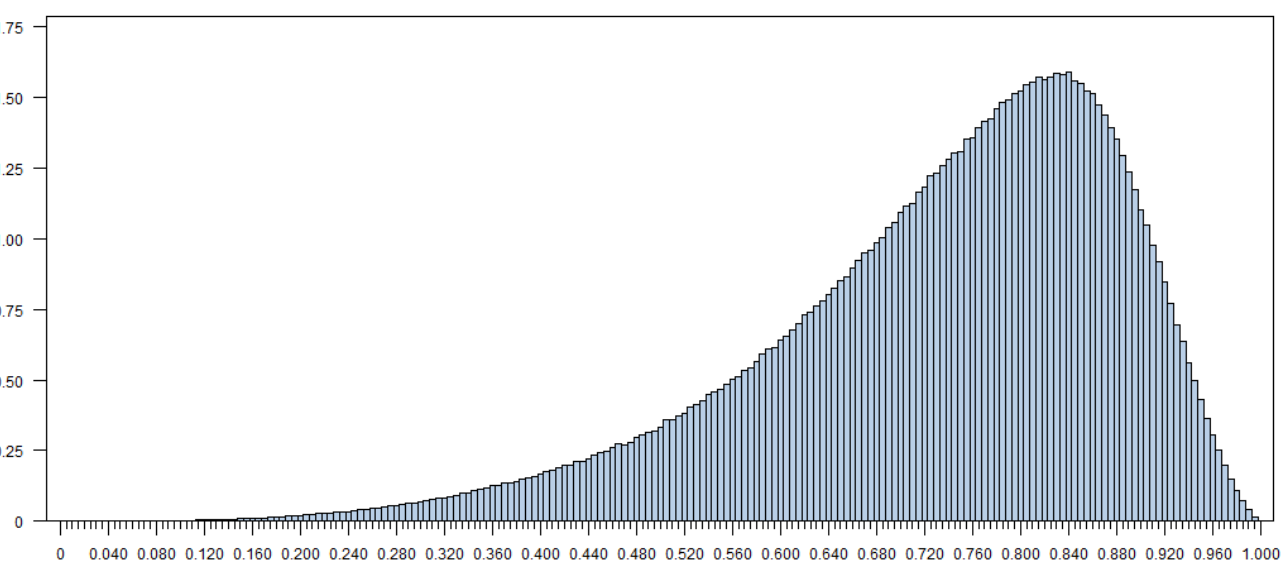
Figure 12. Distributions of the quality measures Q 4 (standardized version of MX ) and Q 5 (standardized version of MN ), of the mesh of the real model of the bouton. Probability (percent) − vertical